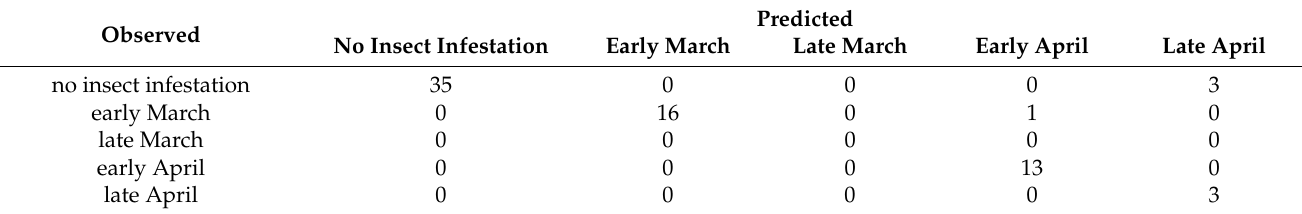
Table 5. Confusion matrix of pest outbreak date from 2009 to